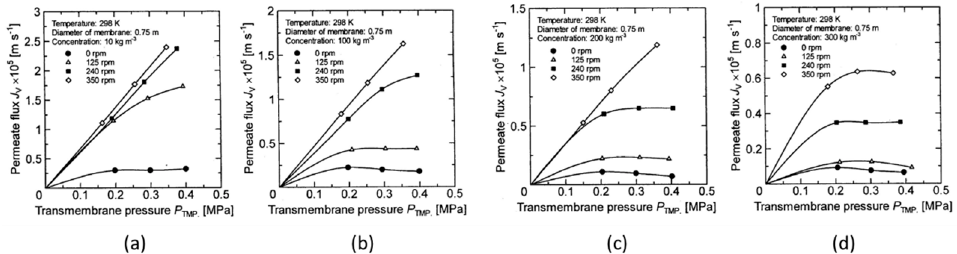
Figure 8. Relationship between measured TMP and permeate flux for disk diameter 0.75 m. ( a ) at latex concentration 10 kg/m 3 ( b ) 100 kg/m 3 ( c ) 200 kg/m 3 ( d ) 300 kg/m 3 .